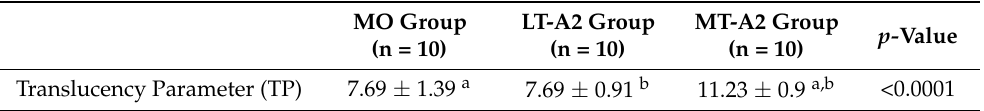
Table 2. Mean values ( ± SD) for the Translucency Parameter in the three groups concerning 1 mm thick veneers. a and b indicate a p- value < 0.001 between the two concerned groups.